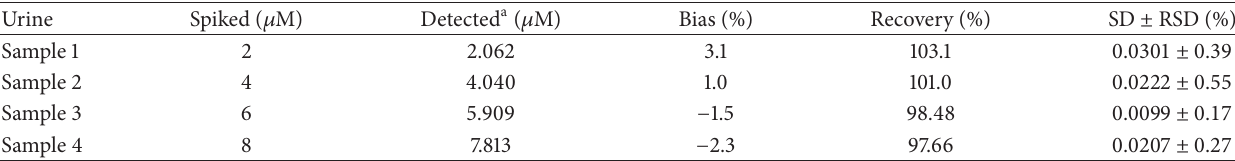
Figure 7: Typical square wave voltammograms on GCE in (a) 6-propylthiouracil solution at different concentrations (i) 2 𝜇 M, (ii) 4 𝜇 M, and (iii) 6 𝜇 M in tablet solutions and (b) 2-thiouracil solution at different concentrations (i) 2 𝜇 M, (ii) 4 𝜇 M, and (iii) 6 𝜇 M in urine samples. Table 5: Determination of 2-thiouracil in urine